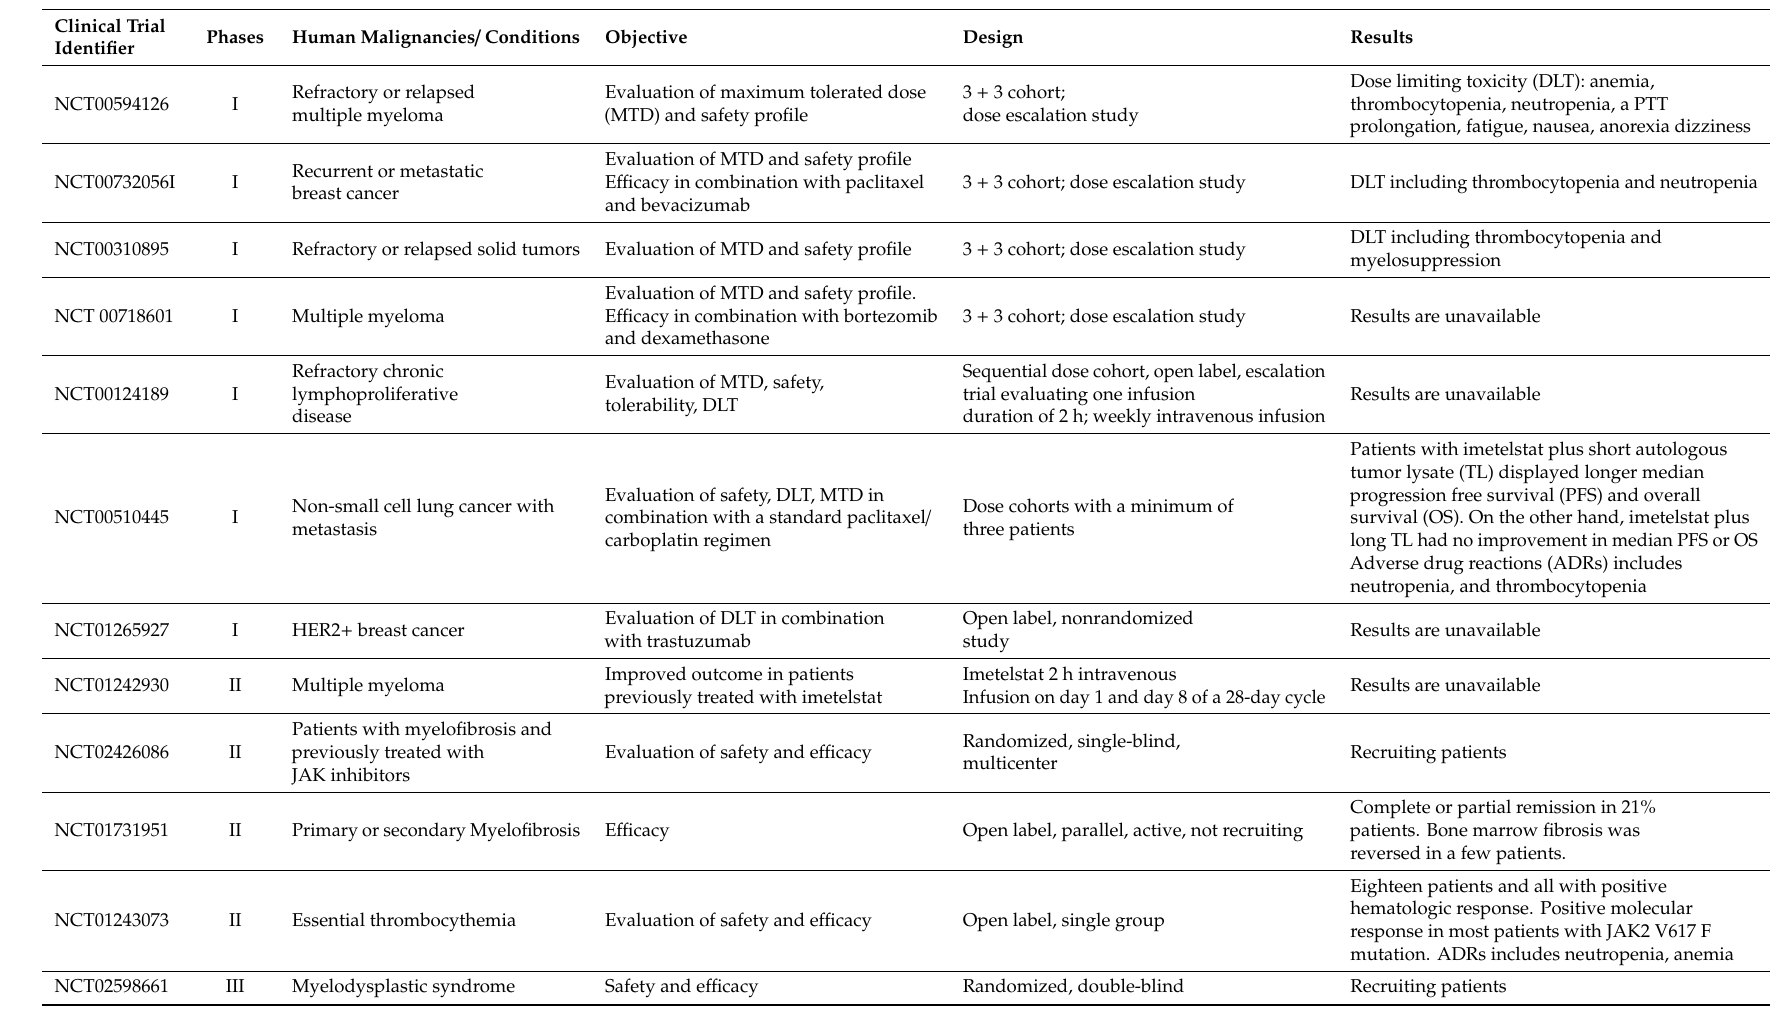
Table 3. Details of imetelstat (GRN163L: telomerase inhibitor) in clinical trials against several human malignancies. Clinical Trial